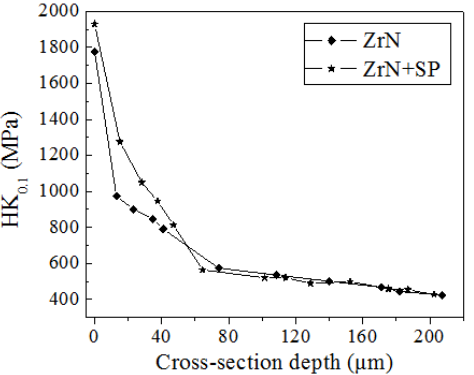
Figure 10. Microhardness distribution along depth of the ZrN and ZrN+SP layers.